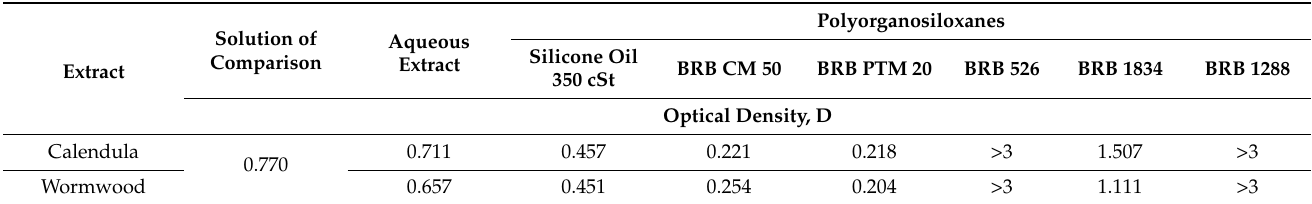
Table 5. Antioxidant activity of the silicone